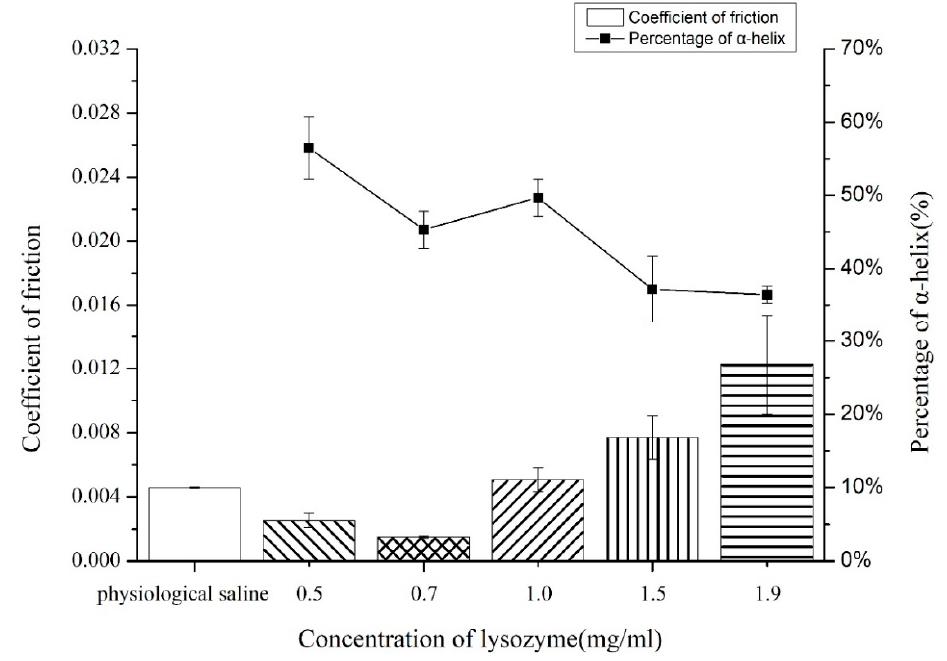
Figure 3. The friction coefficient of the Polymacon contact lens covered with lysozyme adsorbed from different solution concentrations. The friction coefficient of the Polymacon surface with no protein adsorbed in a physiological saline solution was measured as a control . The error bars denote the mean ± SD for n = 3.